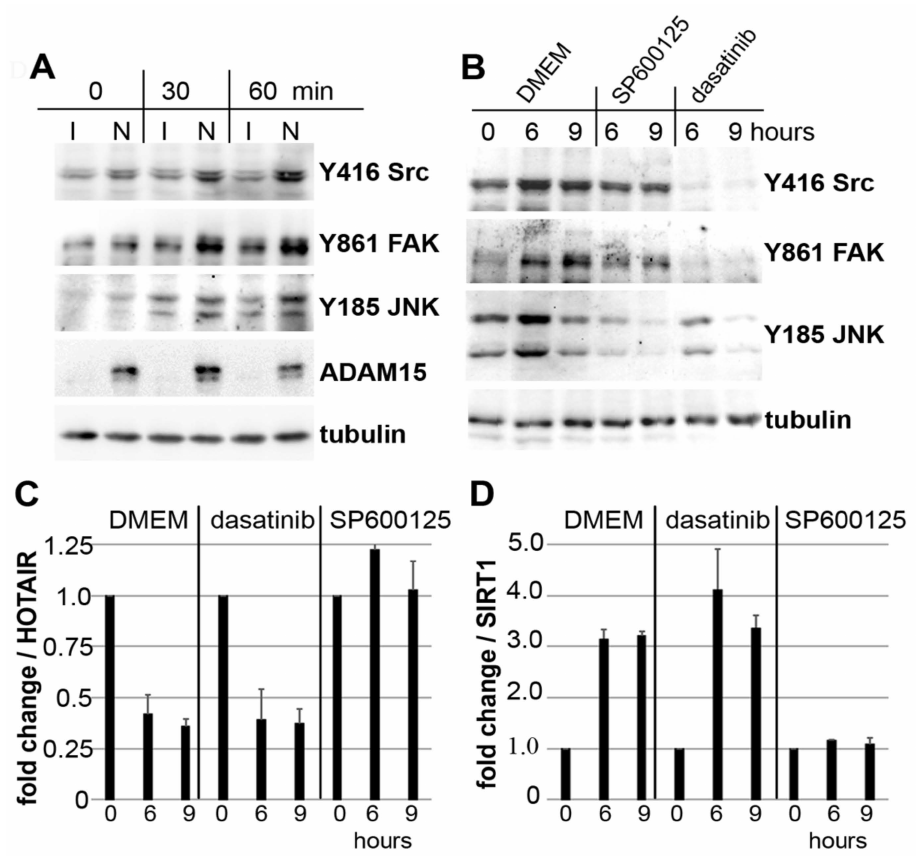
Figure 4. Impact of JNK inhibition on ADAM15-mediated HOTAIR and SIRT1 regulation by mechanosignaling. ( A ) Immunoblots of SF mechanically strained for 30 and 60 min, with prior down- regulation of ADAM15 by siRNA (I) and non-silencing siRNA (N) as control, showing ADAM15- dependent activation of Src, FAK and JNK. ( B ) Immunoblots of SF strained in the presence of the JNK inhibitor SP600125 or the Src inhibitor dasatinib. Tubulin served as a loading control. ( C ) Fold change of HOTAIR and ( D ) SIRT1 mRNA levels, calculated by the 2 − ∆∆ Ct method, comparing DMEM control with the respective inhibitor. Mean values ± SD from 6 different donors are